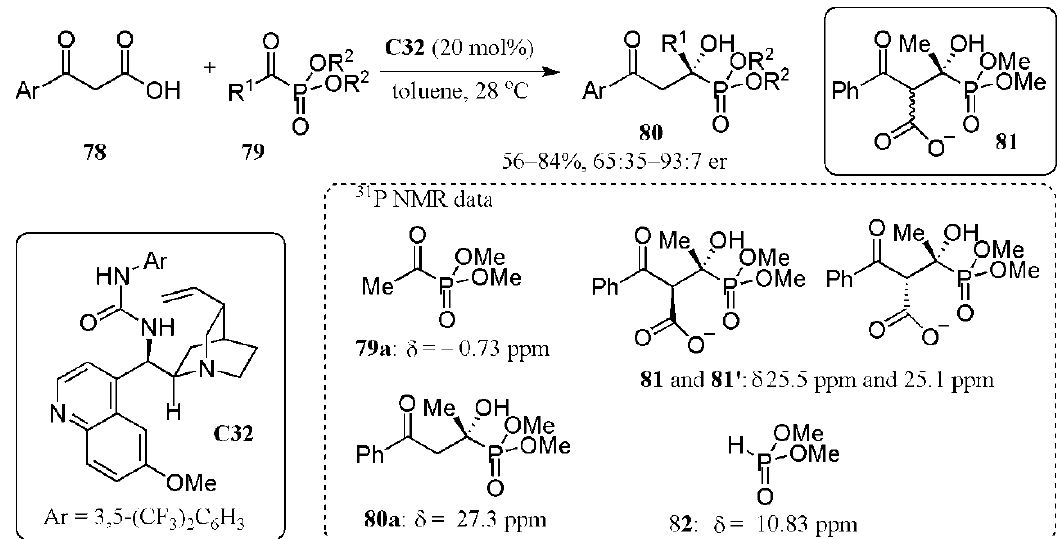
Figure 43. Organocatalytic synthesis of tertiary α -hydroxyphosphonates [83].